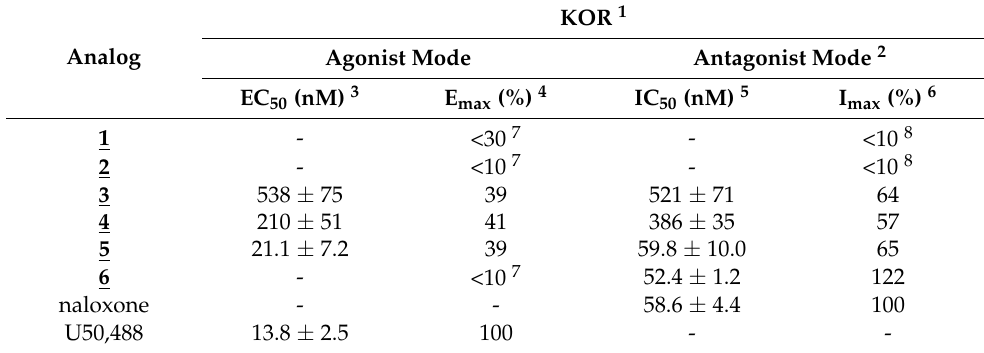
Table 2. [ 35 S]GTP γ S assays of enkephalin analogs at the KOR.